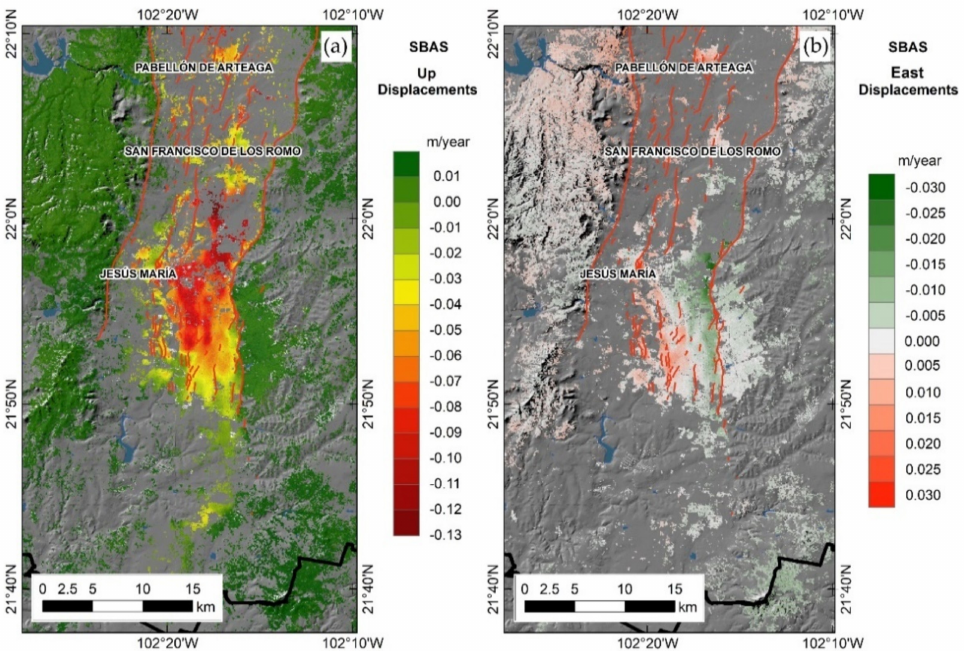
Figure 5. SBAS results: displacement velocity in 2014 − 2016 along the ( a ) vertical V U and ( b ) east-west V E directions. The V LOS observed within the state with the PSI method ranged between − 113 and +40 mm/year for the ascending dataset and between − 103 and +48 mm/year for the descending one. The combined dataset revealed minimum and maximum rates of − 141 and +46 mm/year for the V − 64 and +68 mm/year for the V U and E (Figure 6).